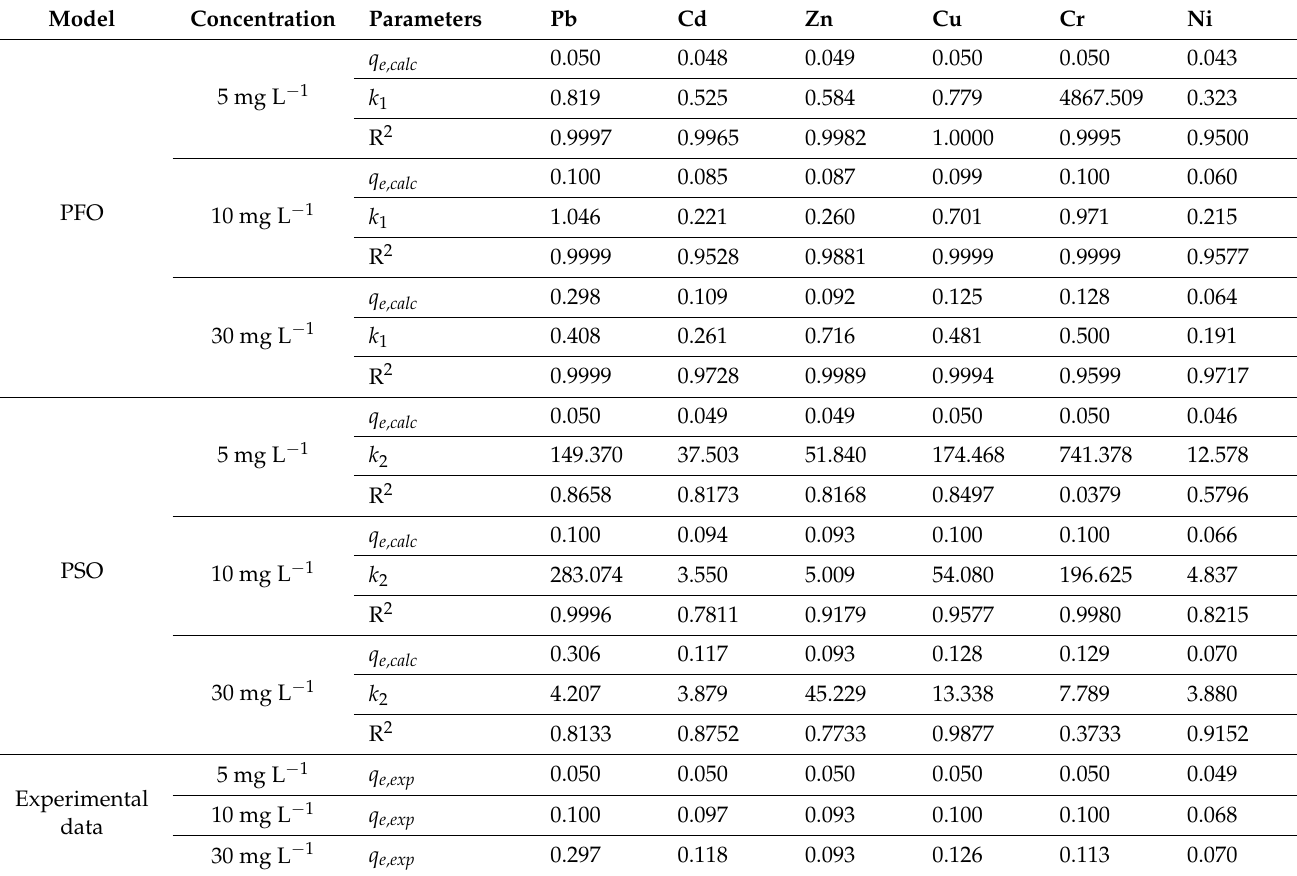
Table 5. PFO and PSO kinetic parameters for Pb, Cd, Zn, Cu, Cr, and Ni ions sorption onto zeolite with a 0–0.05 mm particle size thermally treated at 200 ◦ C.